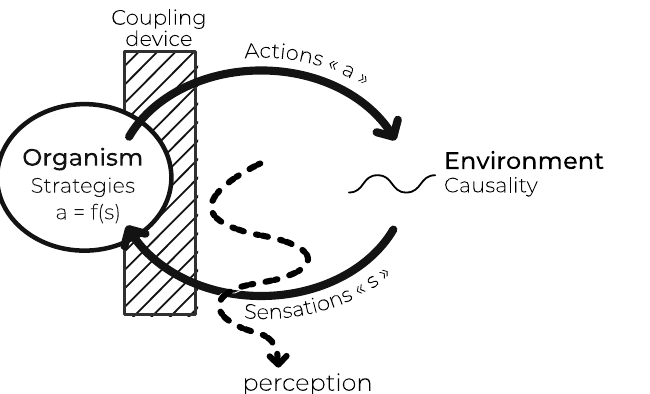
Figure 1. The augmented sensorimotor relation of perception spans the organism, coupling devices, and the environment. The coupling device could be any kind of tool, but the extension of perceptual experience becomes more marked with the skilled use of mind-enhancing tools, including sensory substitution devices and the advanced instrumentation used in scientific observation. Figure redrawn from Lenay and Steiner [31].